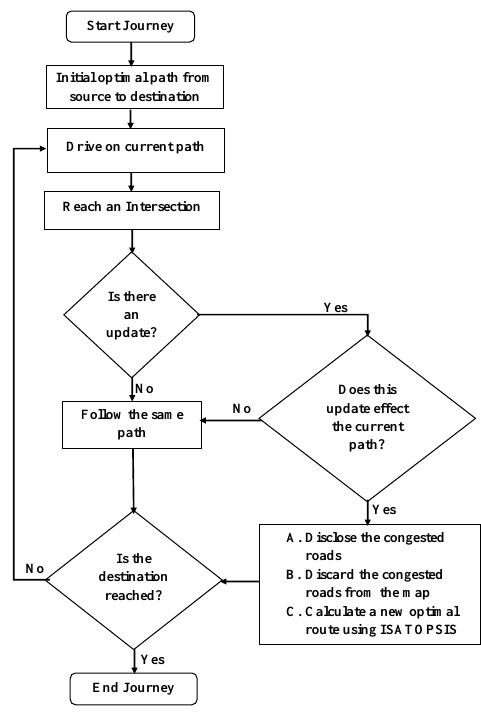
Figure 4. Flow chart of the simulated annealing (SA) congestion avoidance